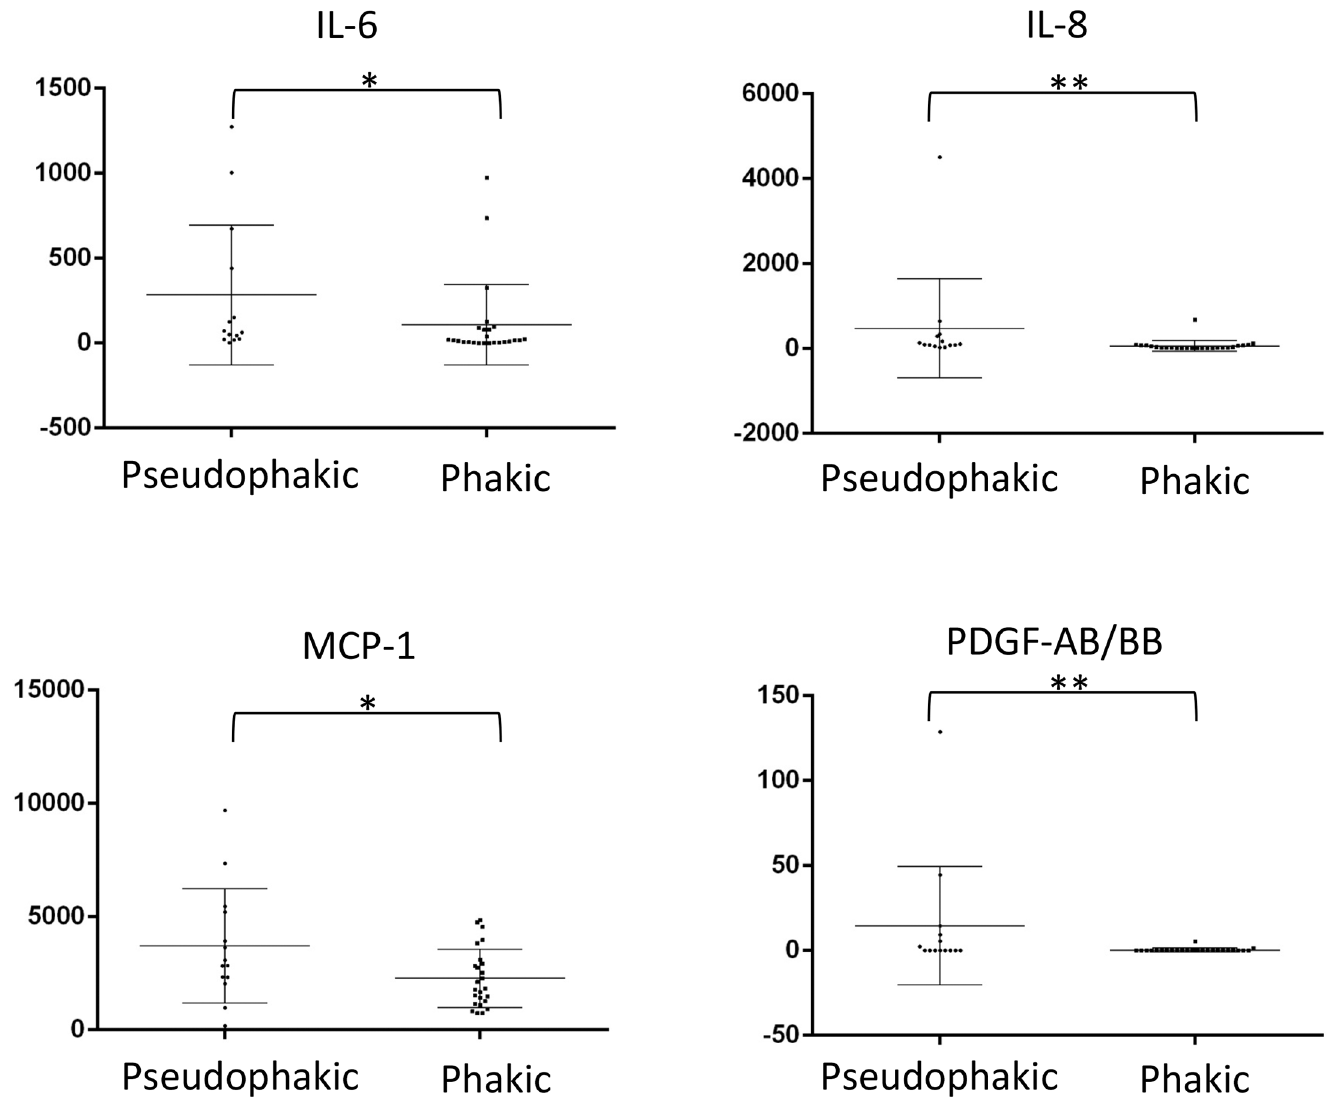
Fig 2. Comparison of levels (pg/mL) of analytes in the eyes of UG cases between with (pseudophakic) and without (phakic) a history of phacoemulsification. Data points ( n = 14 for with history of phacoemulsification, and 25 for without history of phacoemulsification) represent individual samples. Error bars indicate medians ± interquartile range. * P < 0.05, ** P < 0.01. IL, interleukin, MCP, monocyte chemotactic protein, PDGF, platelet- derived growth factor.